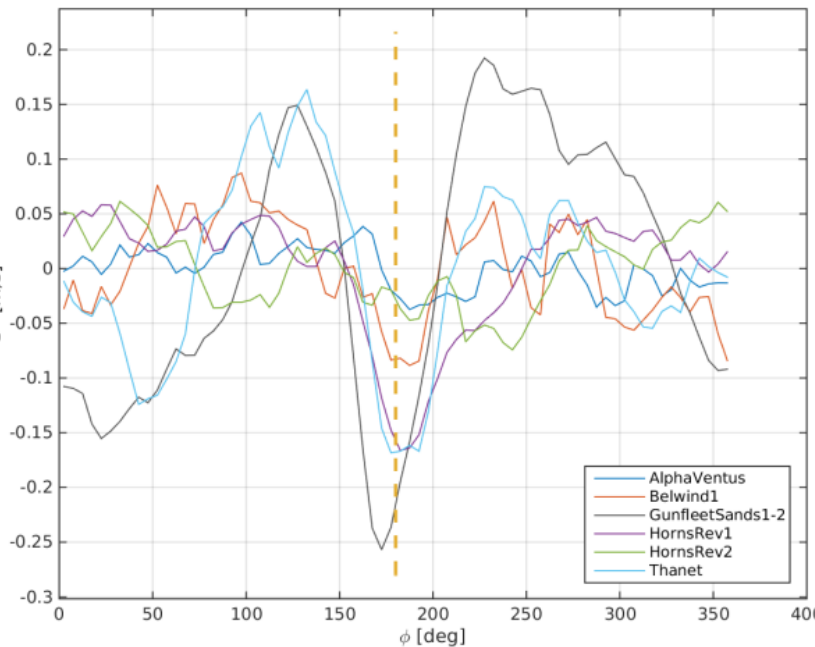
Figure 14. SAR-based wind farm wake observed at six wind farms, Alpha ventus, Belwind 1, Gunfleet Sands 1 + 2, Horns Rev 1, Horns Rev 2 and Thanet, showing the wake wind speed deficit ( S D